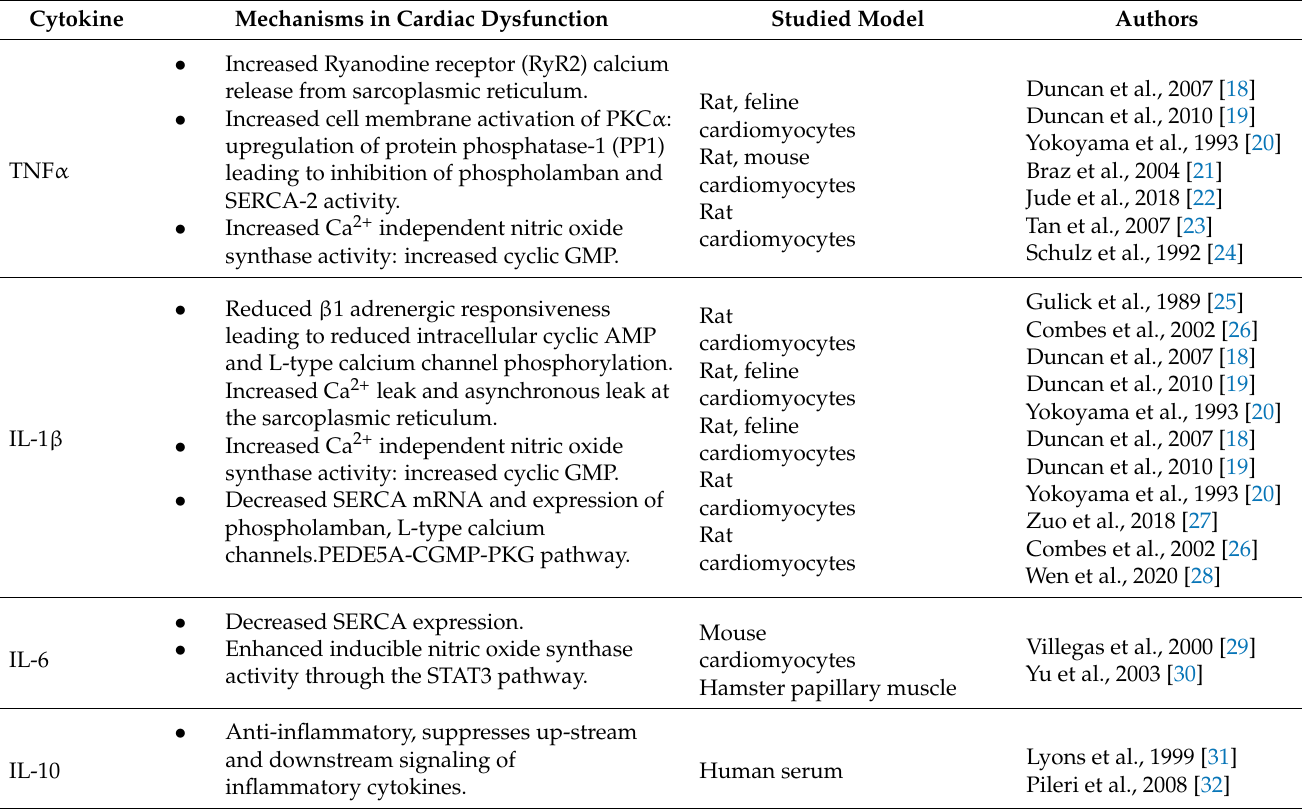
Table 1. Summary of discussed cytokines and mechanisms involved in burn-related cardiac dysfunction. Studied